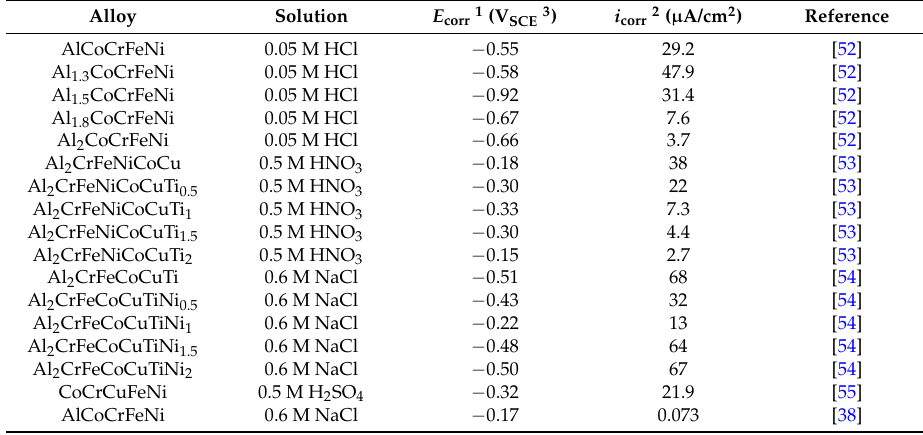
Table 3. Electrochemical parameters of HEAs coatings in the aqueous environment at room